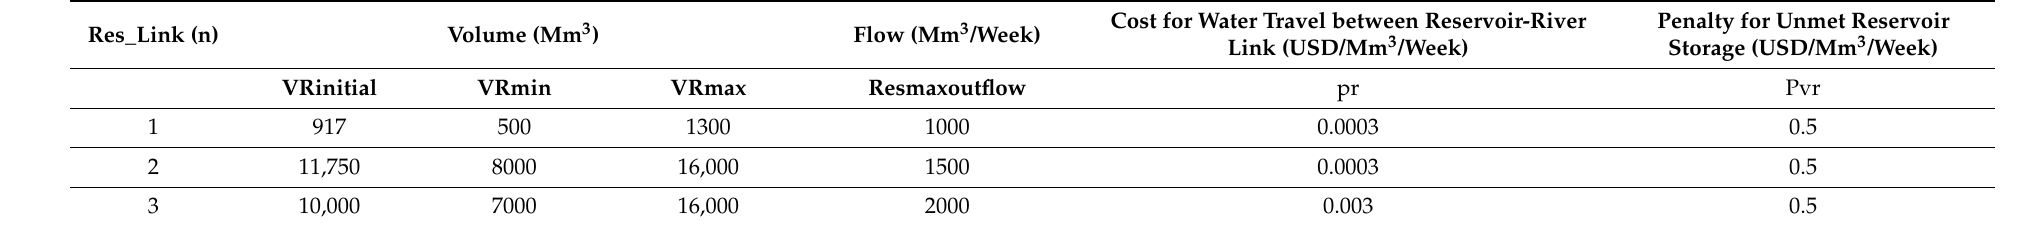
Table 7. Input data used in the model for reservoir link part